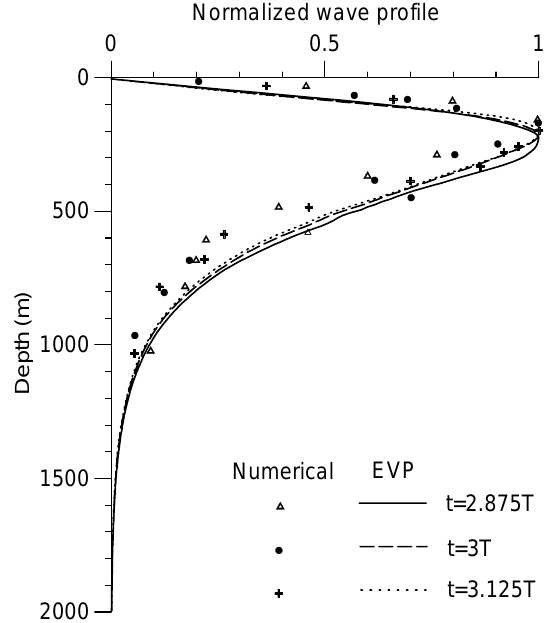
Fig. 10. Normalized profiles of vertical displacement of short waves calculated in vertical sections a − a , b − b , and c − c shown in Fig. 8. Vertical displacement was calculated as a distance between solid and dashed lines (see Fig. 8). Solid, dashed and dotted lines repre- sent the vertical profiles of the first eigen function of the eigen-value problem (Eqs. 1–2) calculated for t = 2 . 875 T , 3 . 0 T and 3 . 125 T , re-